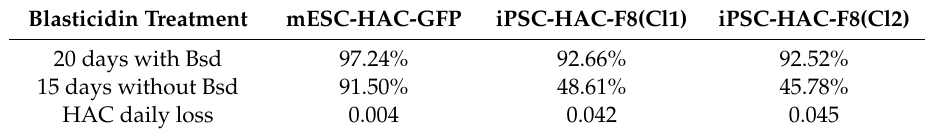
Table 1. The rates of human artificial chromosome (HAC) vector loss during cell division. HAC vectors daily losses determined based on the fluorescence-activated cell sorting assay.